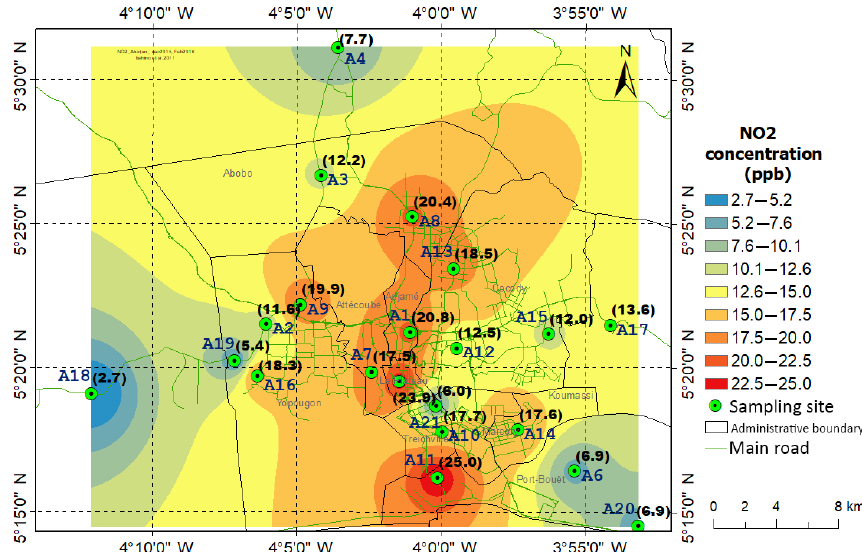
Figure 7. Spatial distribution of NO 2 in the district of Abidjan during the dry season (15 December 2015–16 February 2016). Measured concentrations in ppb are in